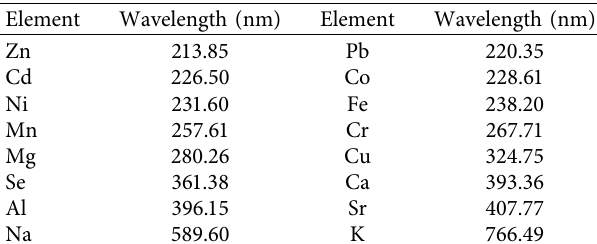
Table 2: Analysis of wavelengths of 16 mineral elements in free-range and caged